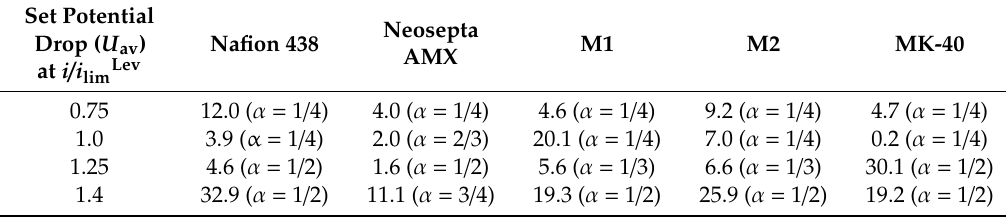
Table 1. The values of the maximum average increment in measured current over the period, ω (%) *, at the most e ff ective duty (the value of α is indicated in round brackets) in the pulsed electric field (PEF) mode compared to the DC